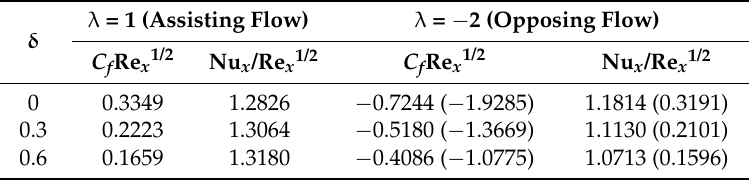
1 2 Re / Table 3. The values of C f Re 1 { 2 x and Nu x { Re 1 { 2 x for different values of δ when ε = 1 and Pr = 1. and 1/2 Nu / Re for different values of δ when ε = 1 and Pr = 1. f x λ = 1 (Assisting Flow) λ = ´ 2 (Opposing Flow) δ C f Re x